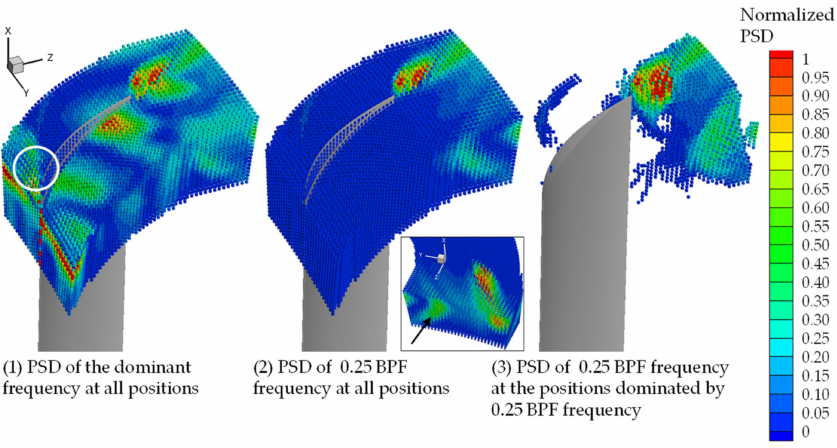
Figure 21. PSD analysis of